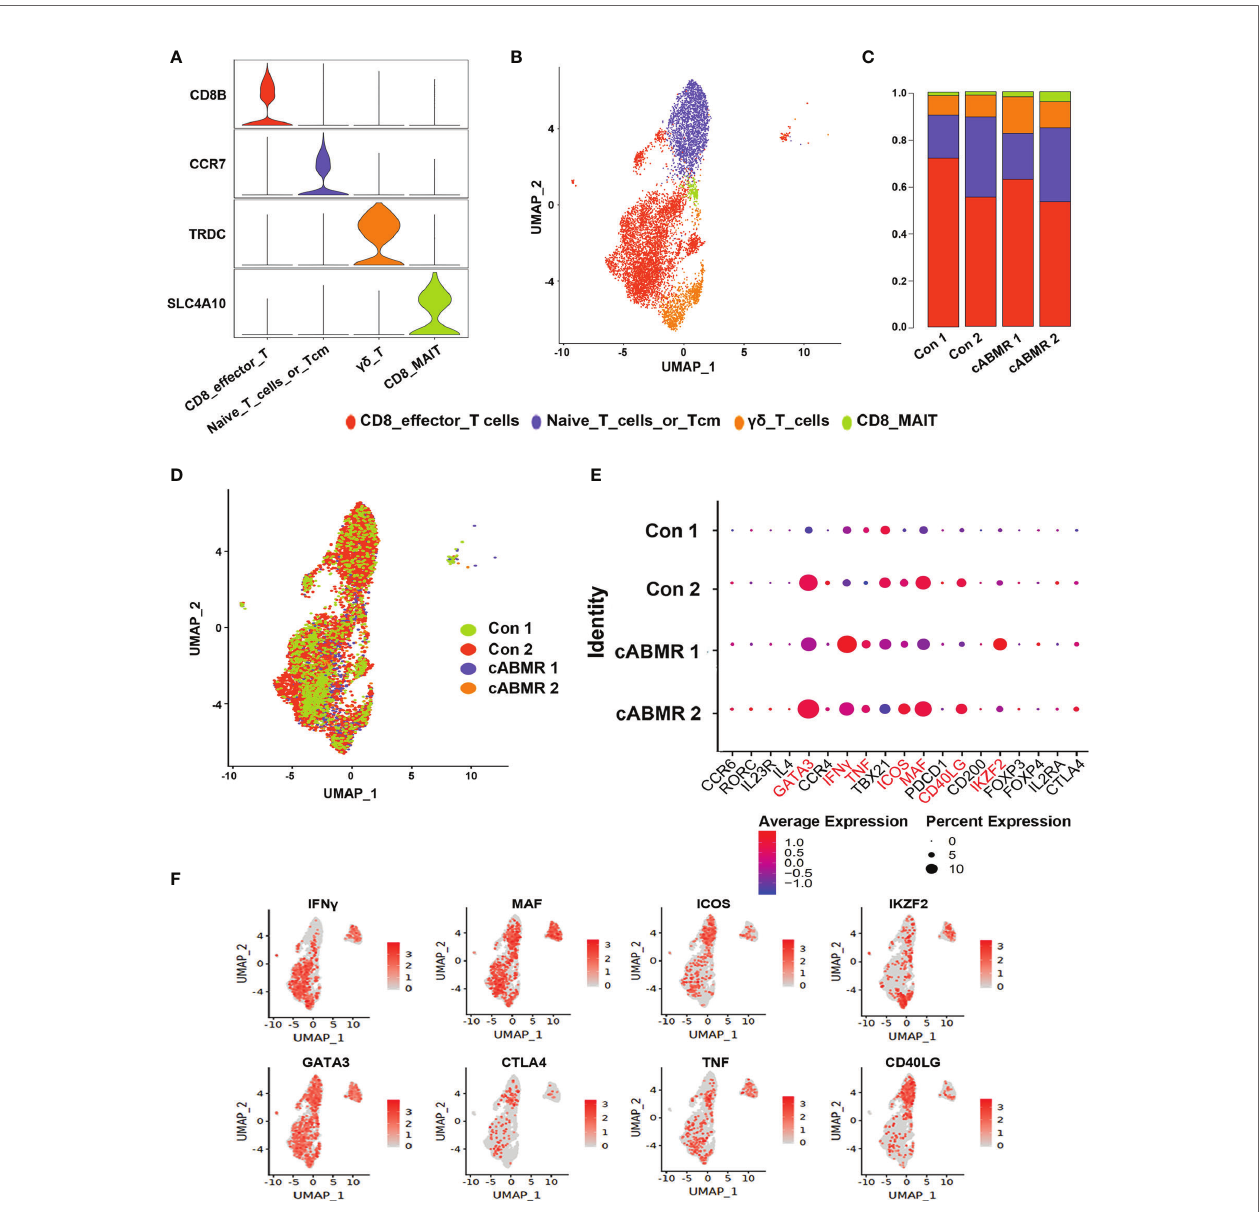
FIGURE 3 | Immunological characteristics of T cell subsets. (A) The violin plot shows the distribution of selected marker genes in 4 subsets of T cells, with columns representing selected marker genes and rows representing subsets of the same color as in (B) ; (B) UMAP dimensional-reduction projection analysis of samples from the control group and the cABMR group, which was stained by cell type source; (C) The proportion of T cell subsets from the Control (n=2) and cABMR (n=2) samples; (D) UMAP dimensional-reduction projection analysis of samples from the control group and the cABMR group, which was stained by sample source, each dot corresponds to a single cell; (E) DEGs node maps of T cells in the control and cABMR samples, the size of the dot indicates the proportion of expression, and the shade of color indicates the average expression amount; (F) Canonical cell markers were used to label clusters by cell identity as represented in the T cell UMAP plot. Data are colored according to expression levels and the legend is labeled in log